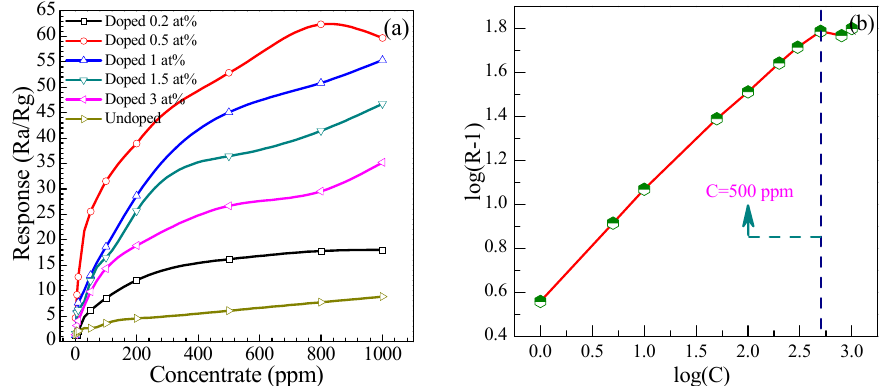
Figure 11. ( a ) Gas response to methanal concentrations; ( b ) The linear relationship between R and C in logarithmic forms of 0.5 at % Eu-doped SnO 2 nanorods array sensor.